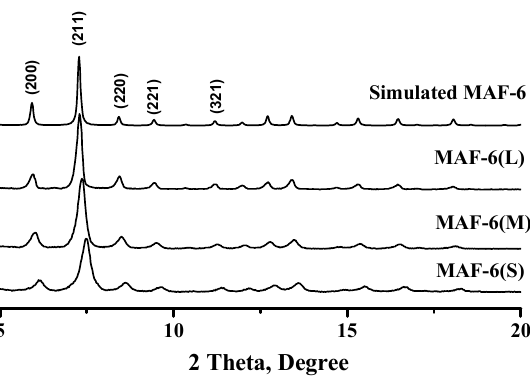
Figure 2. XRD patterns of MAF-6 with different particle sizes. Where D XRD is particle size (nm), β is the full-width at half maximum of the peak (radian), Θ is the Bragg angle of diffraction peak (grad), and λ is X -ray wavelength of CuK α (0.1542 nm). The D XRD value for MAF-6 was found to change in the following order (Table S2, Supporting